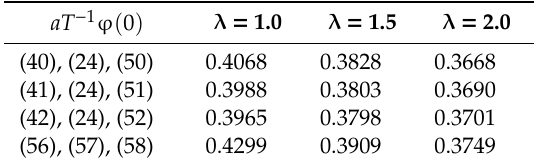
Table 2. Relative contact stresses aT − 1 ϕ ( 0 ) for a = 1 m and di ff erent λ . aT − 1 ϕ ( 0 ) λ = 1.0 λ = 1.5 λ = 2.0 (40), (24),